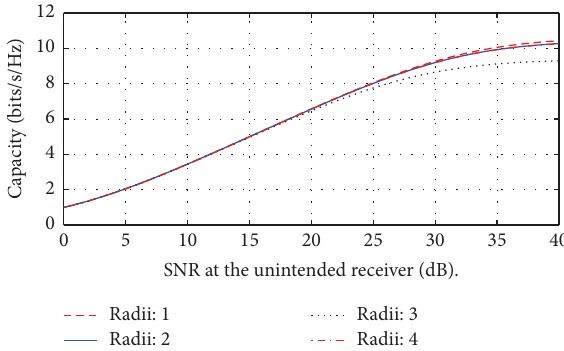
Figure 23: Capacity comparison: unintended receiver at (30 de- grees azimuth, 35 degrees elevation). Te radius values are wavelength normalized.